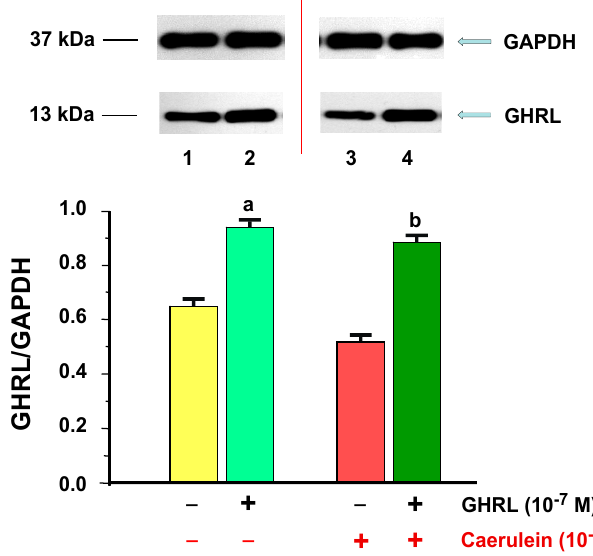
Figure 8. Analysis of ghrelin (GHRL) protein production determined by the methods of immunoblotting and immunoprecipitation, and densitometric analysis of GHS-R1A/glyceraldehyde-3-phosphate dehydrogenase (GAPDH) protein ratio in AR42J cells: (line 1) control cells incubated in caerulein-and GHRL-free solution; (line 2) cells incubated in caerulein-free solution containing GHRL at a concentration of 10 − 7 M; (line 3) cells incubated in solution containing caerulein at a concentration of 10 − 8 M without addition of GHRL; (line 4) cells incubated in solution containing caerulein at a concentration of 10 − 8 M and GHRL at a concentration of 10 − 7 M. Reference protein: GAPDH. a p < 0.05 compared to control cells incubated in caerulein-and GHRL-free solution (line 1); b p < 0.05 compared cells incubated in solution containing caerulein without addition of GHRL (line 3). In each experimental group, the number of observations was at least 6.